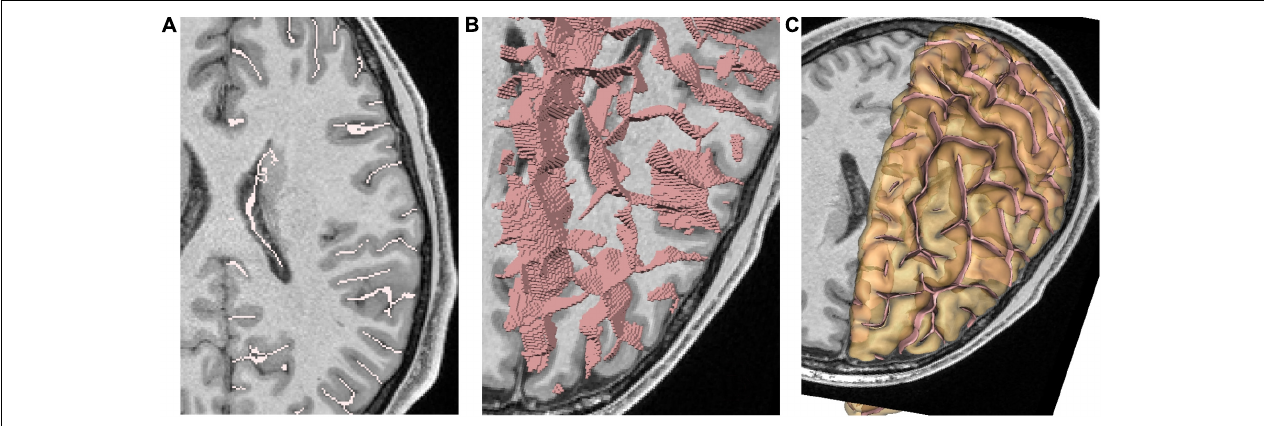
FIGURE 2 | Representation of cortical folds using Morphologist; each fold is represented by a local negative cast of the cortex, usually corresponding to the cerebrospinal fluid, which fills up the fold. (A) 2D representation of folds. (B) 3D representation as voxels lists. (C) 3D representation as meshes. The hemisphere pial mesh is also displayed with slight